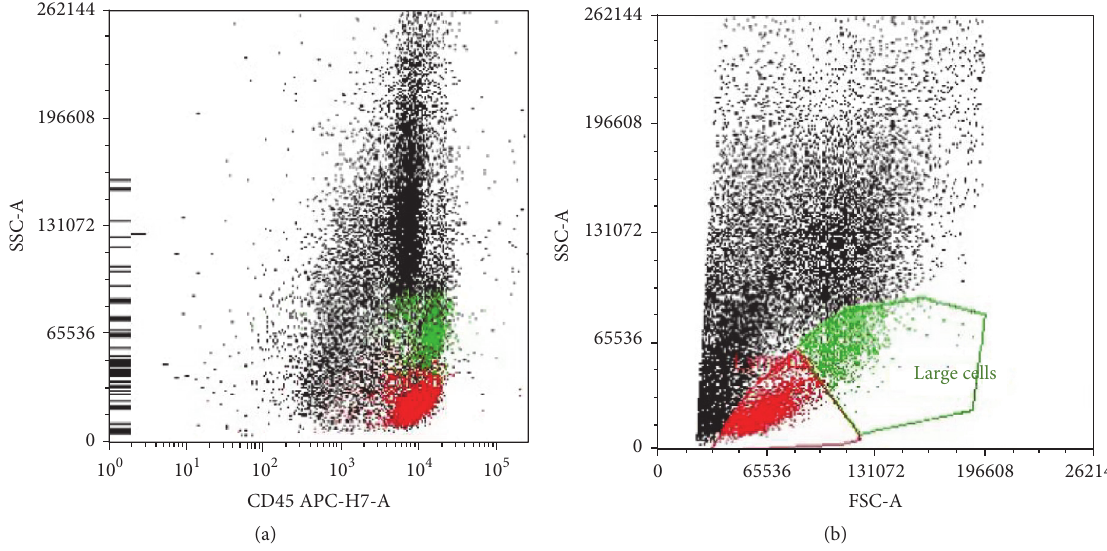
Figure 2: Multiparametric flow cytometry results. CD45+ lymphocyte gate (low SSC-A) was 14% of the total population (a). The lymphocytes were predominantly T cells (12% of total cells; (b)). (a) CD45 versus SSC and (b) FSC versus